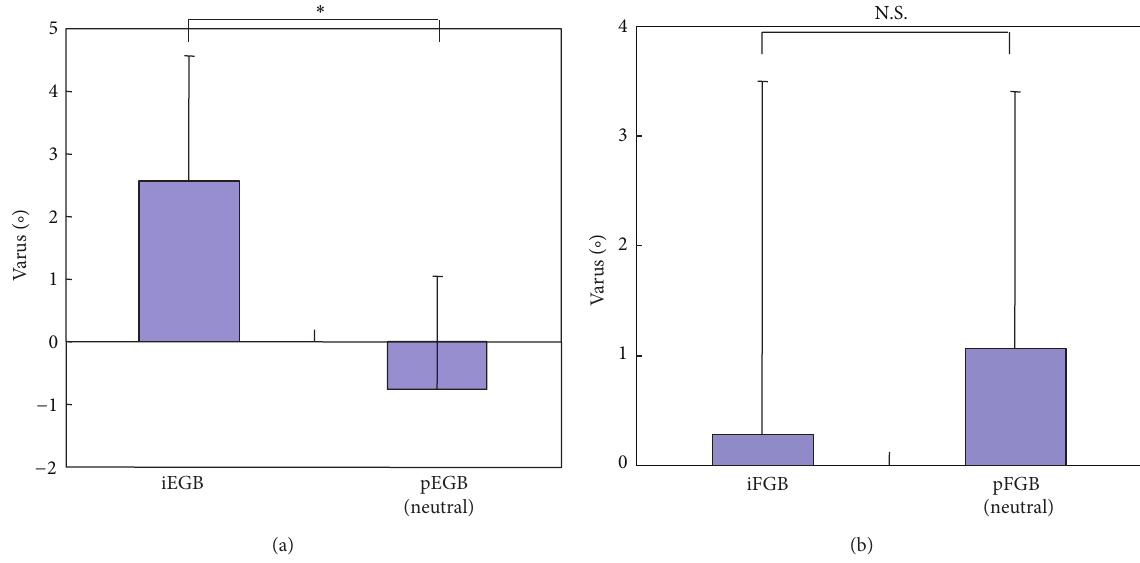
Figure 3: Changes in joint gap balance between intraoperative and postoperative measurements. (a) Intraoperative extension gap balance (iEGB) of 2.6 ∘ varus significantly differs from postoperative extension gap balance (pEGB) of 0.77 ∘ valgus in neutral position ( ∗ 𝑃 < 0.01 ). (b) No significant difference is observed between intraoperative flexion gap balance (iFGB) and postoperative flexion gap balance (pFGB) in neutral